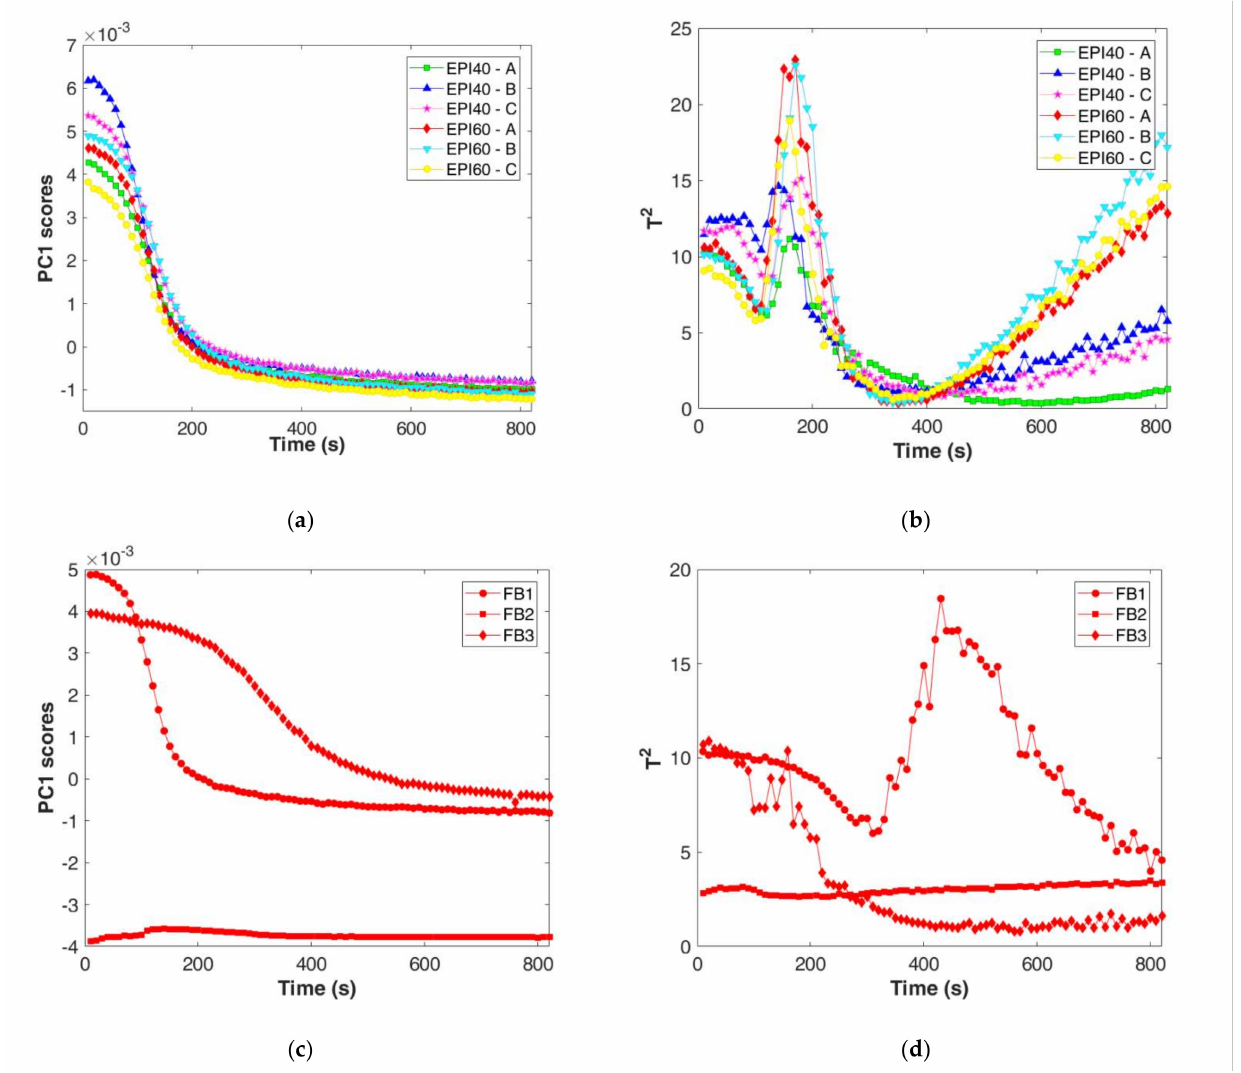
Figure 5. Multivariate statistical process control chart for the test datasets: ( a ) zoom on PC1–MSPC chart in the first 800 s for EPI40 and EPI60; ( b ) zoom on T 2 –MSPC chart in the first 800 s for EPI40 and EPI60. ( c ) PC1–MSPC chart for failure batches (FB1, FB2, and FB3); ( d ) T 2 –MSPC chart for failure batches (FB1, FB2, and